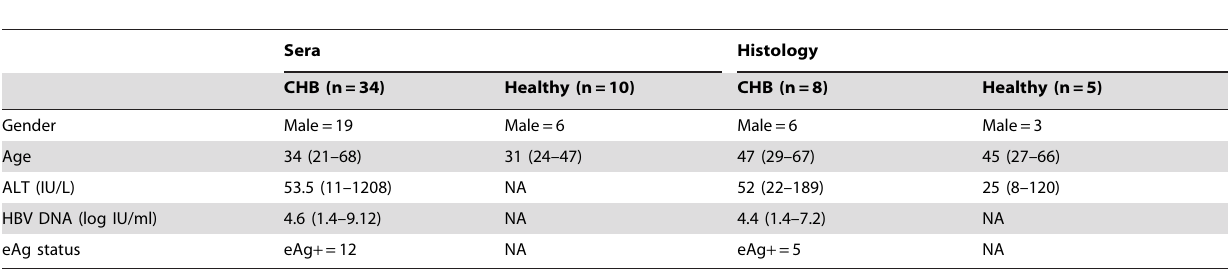
Table 2. Clinical details of patient who underwent liver biopsy and galectin-9 quantification from serum samples.